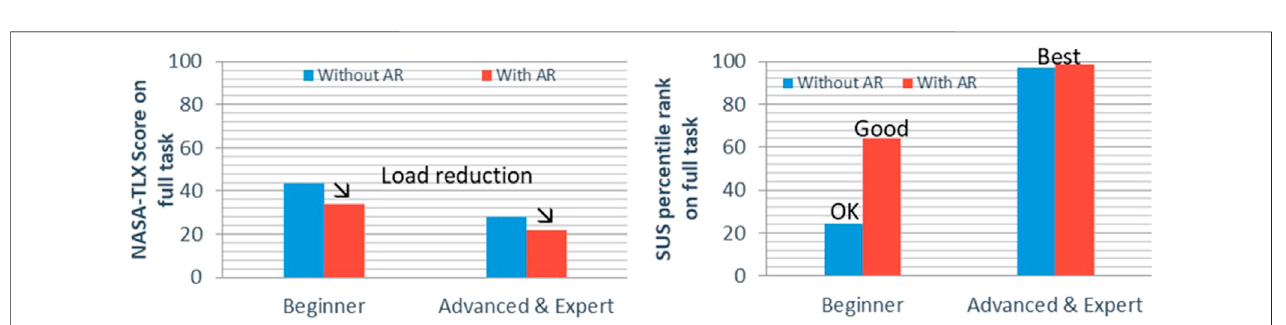
FIGURE 11 | Mean TLX score and SUS percentile rank in both conditions for each pro fi le of user.